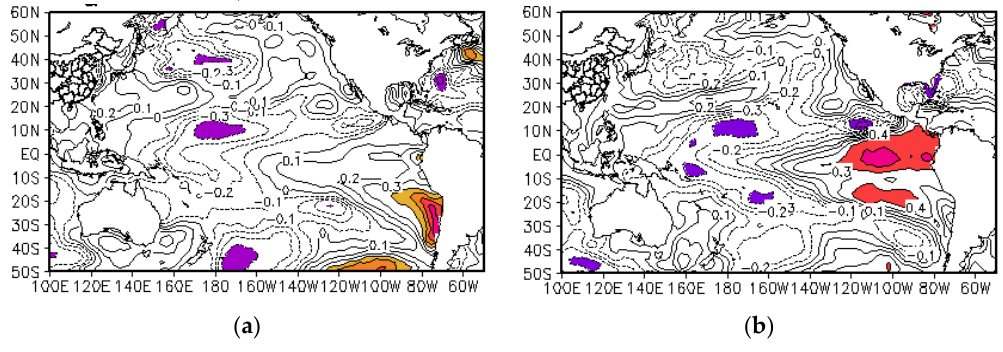
Figure 6. Decadal correlation between the rainfall in PFSSC and Pacific Ocean temperature, January–March ( a ), April–June ( b ) (shaded area indicates 0.05 confidence level, contour interval 0.1).